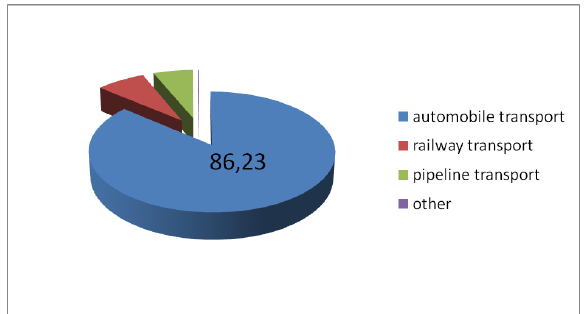
Figure 1. Distribution of total transportation vol- umes among the means of